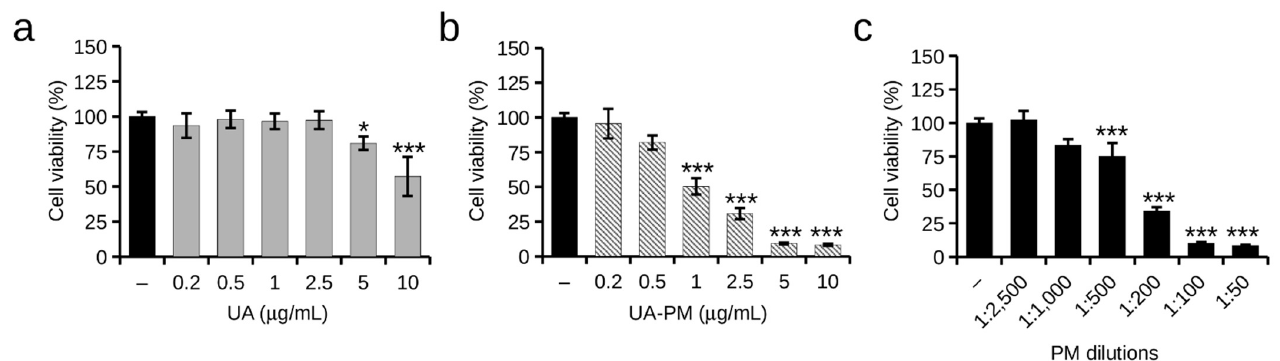
Figure 6. Effect of UA and UA–PM on the viability of SH-SY5Y cells. Cells were treated for 24 h with ( a ) UA at doses ranging from 0.2 to 10 µg/mL, ( b ) UA–PM at concentrations ranging from 0.2–10 µg/mL of loaded UA, and ( c ) corresponding dilutions of vehicle PM. Values are expressed as percentages compared with untreated control cells ( − ). Data are reported as mean ± SD of three independent experiments. Tukey’s test ( n = 3). * p < 0.05, *** p < 0.001 vs. untreated control cells.